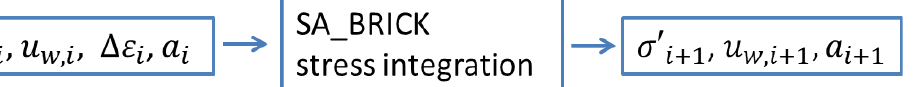
Figure 6. Scheme of the SA_BRICK stress integration procedure in the form of the PLAXIS user- defined soil model.